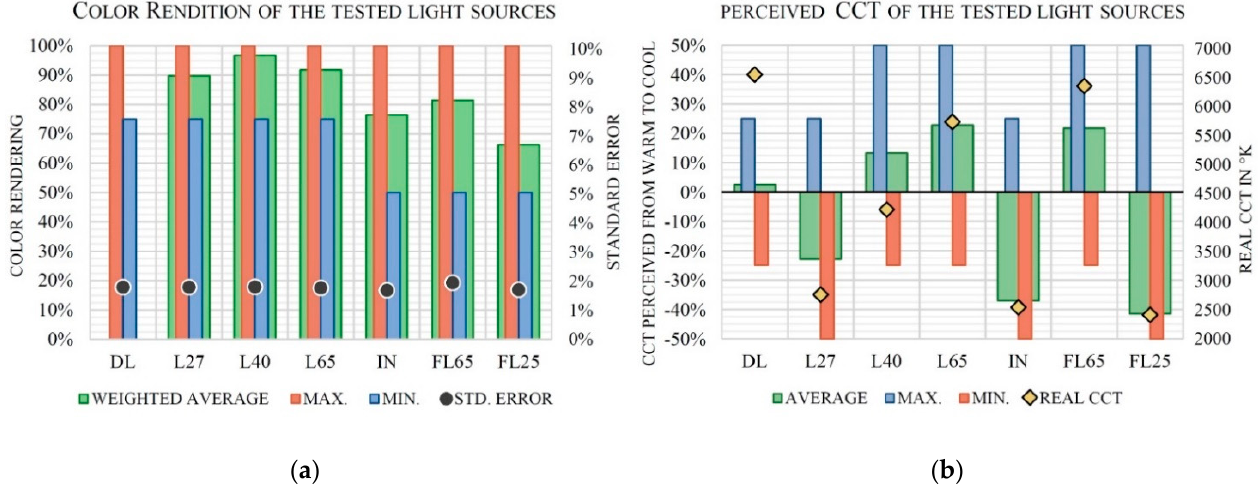
Figure 7. ( a ) Left: Subjective color rendition provided by the tested light sources of the set of color samples. ( b ) Right: Perceived correlated color temperature (CCT) produced by the tested light